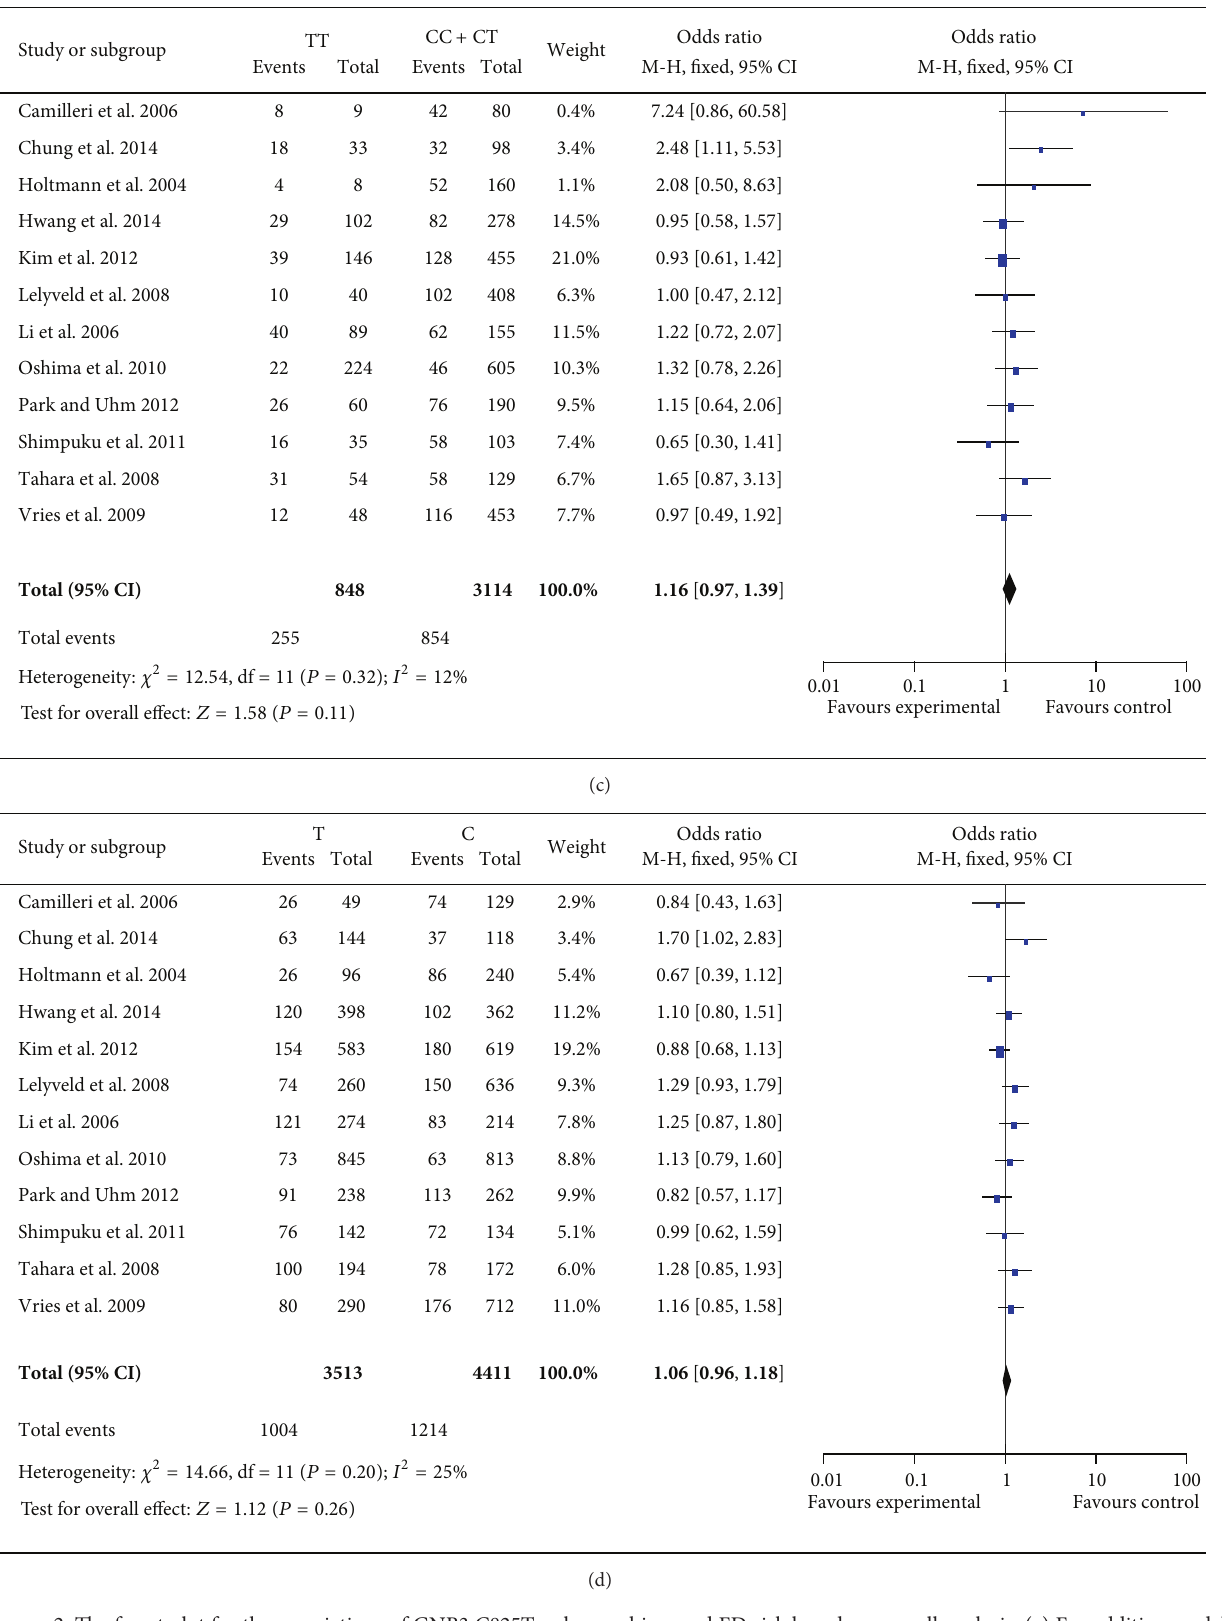
Figure 2: The forest plot for the associations of GNB3 C825T polymorphism and FD risk based on overall analysis. (a) For additive model (CC versus TT). (b) For recessive model (CT + TT versus CC). (c) For dominant model (CC + CT versus TT). (d) For allelic model (C versus